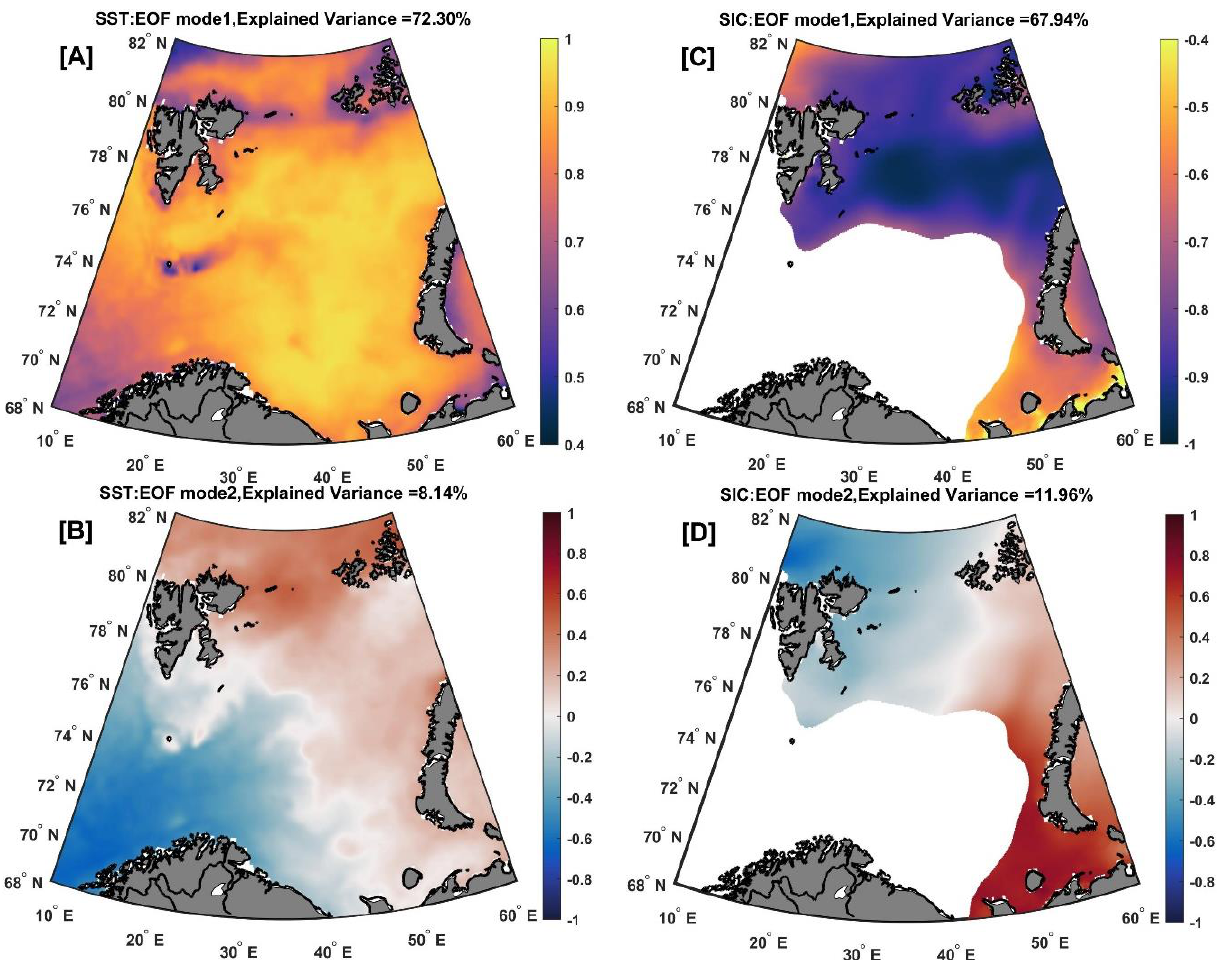
Figure 12. Spatial pattern of the first (top panel) and second (lower panel) EOF modes of the de- seasoned and filtered (13-month running mean) anomalies of SST ( A , B ) and SIC ( C , D ) from 1982 to 2020. The variance explained by each EOF is also given above each panel.